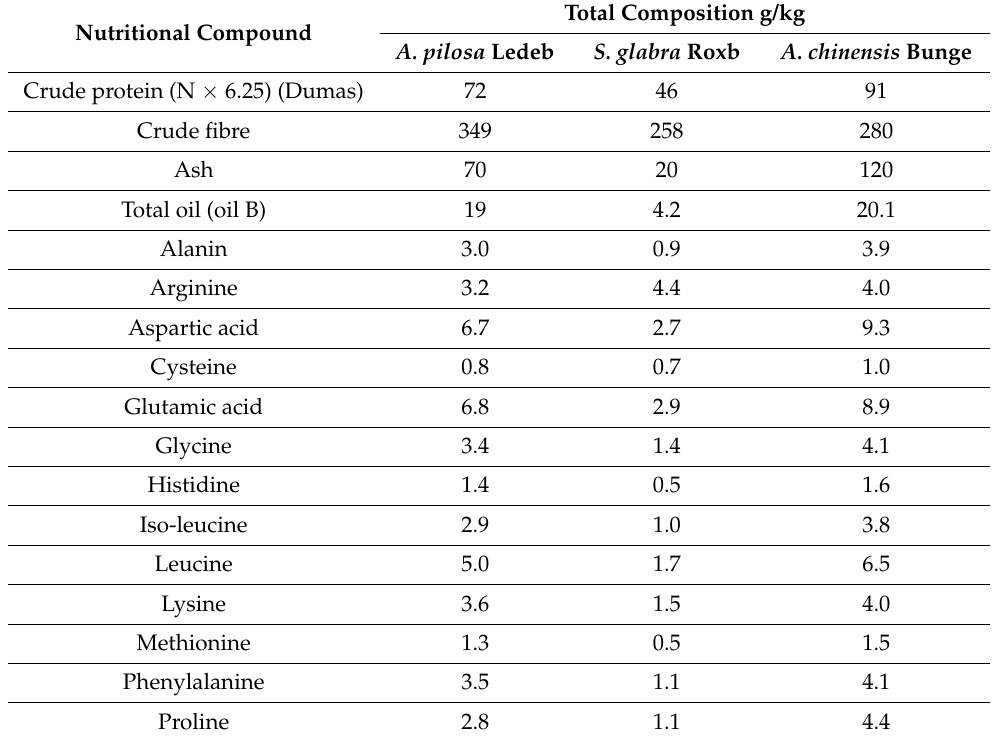
Table 3. Nutritional composition of the dried plants as they arrived commercially dried. Nutritional